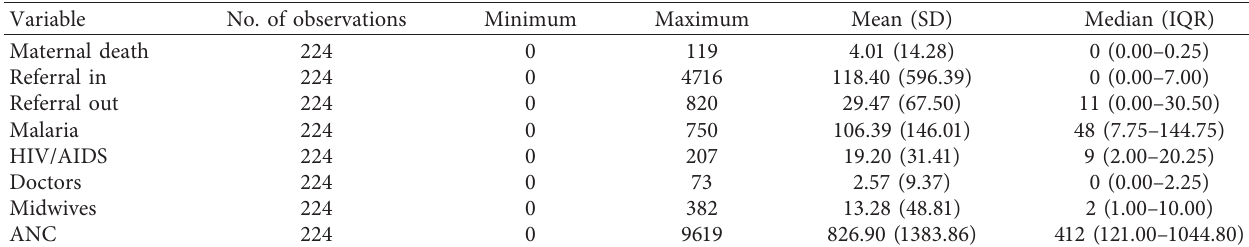
Table 2: Maternal mortality data. Descriptive statistics of the response and explanatory variables. Variable